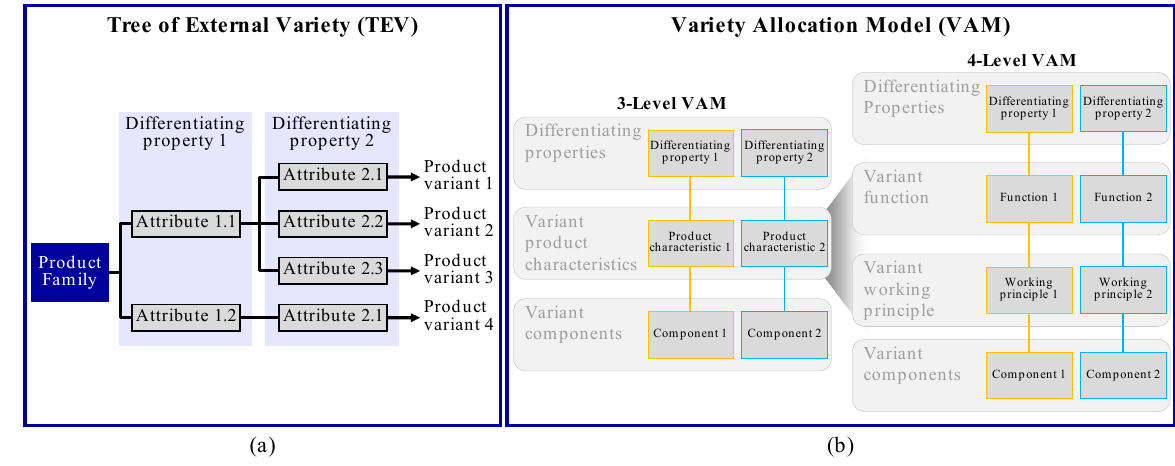
Figure 3. ( a ) Structure of a TEV representing a product family with predefined product variants, and ( b ) structures of a 3-level and 4-level VAM.